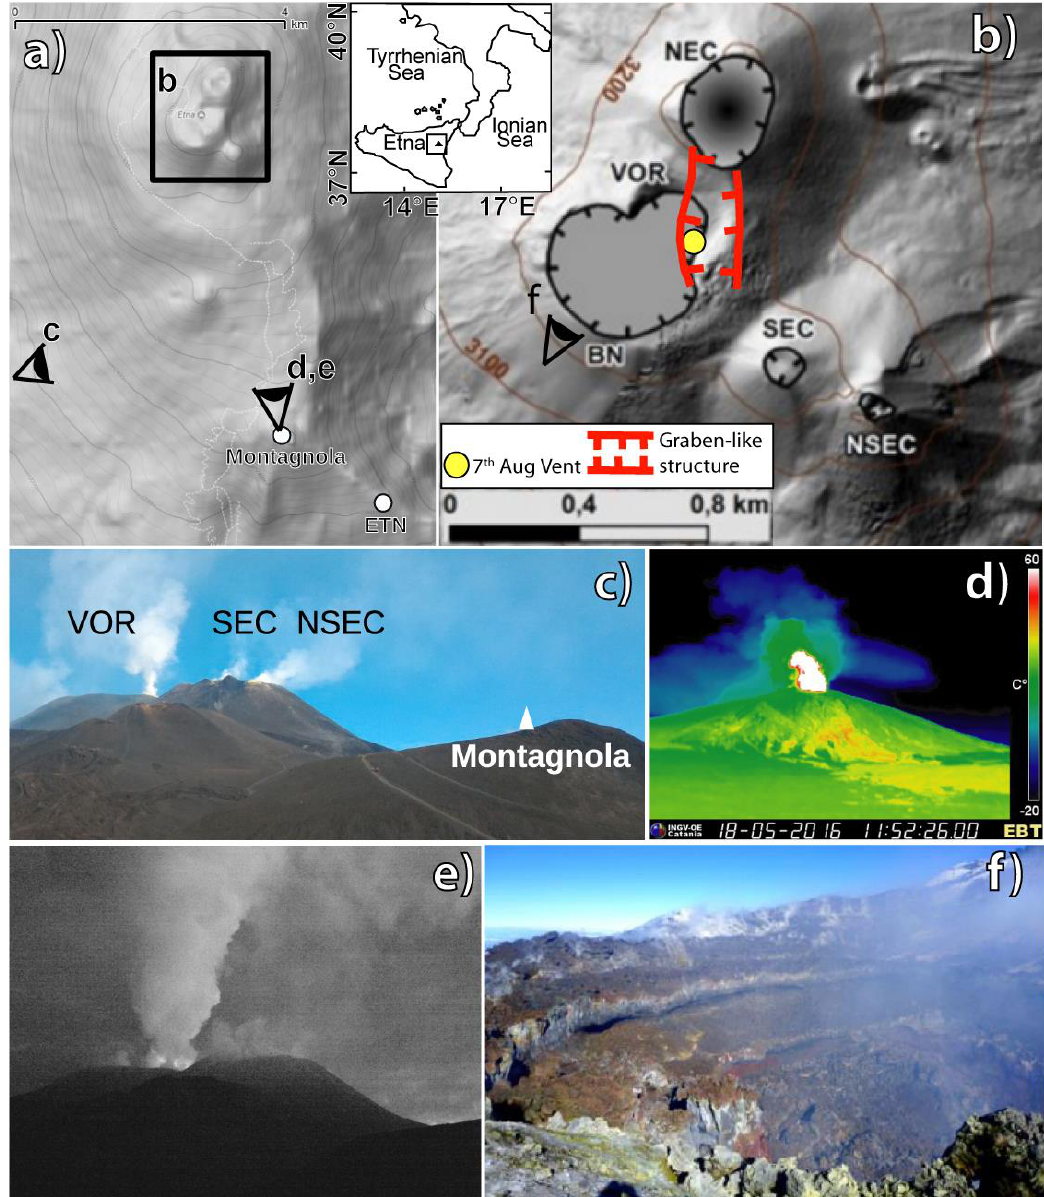
Figure 1. ( a ) The Montagnola site where the UV camera system was installed (position of ETN seismic station is also indicated). Sites from where pictures ( c ), ( d ), and ( e ) have been taken are shown. Black inset identifies the zoomed area of Figure 1b. ( b ) Etna summit area (redrawn from Reference [56]) shows the active summit craters (BN: Bocca Nuova; VOR: Voragine; NEC: North-East Crater; SEC: South-East Crater; NSEC: New South East Crater), the 7 August degassing vent, and the graben-like structure discussed in the text. The site where picture f has been taken is also shown. ( c ) Photo showing the Montagnola site and the summit area. ( d ) Thermal snapshot from INGV-OE monitoring camera capturing the 18 May lava fountaining episode. ( e ) Vigorous degassing from the vent opened on 7 August. ( f ) Picture taken from Reference [56] showing BN crater collapse occurred on 10 October, and marking the end of enhanced degassing activity (see text).